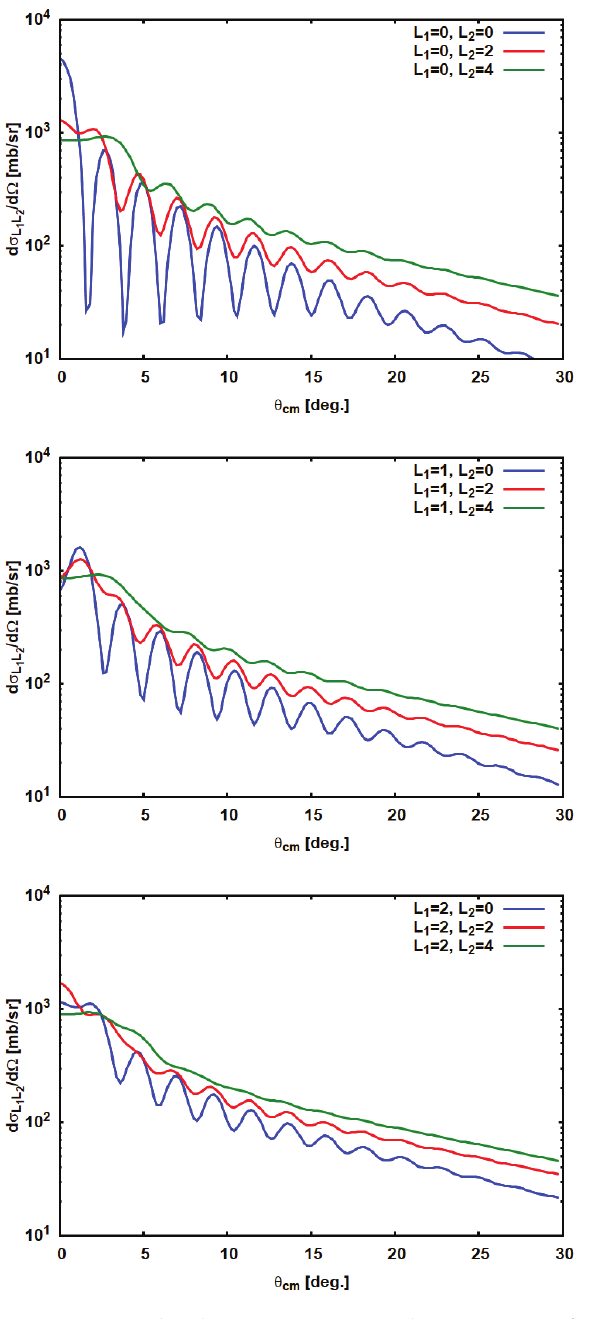
Figure 2. Second-order DSCE unit strength cross sections for the reaction 18 O + 40 Ca → 18 N + 40 Ar at T lab = 270 MeV. From top to bottom, results are shown for total angular momentum transfer in the first single charge exchange (SCE) interaction L 1 = 0,2 and the second SCE interaction L 2 = 0,2,4, respectively. The average excitation energy was chosen as ω γ = 10 MeV. The angular range corresponds to momentum transfers up to 1000 MeV/c. Optical potentials and transition potentials are calculated in a double folding approach by using the (newly derived) nucleon–nucleon (NN) T-matrix at T lab = 15 MeV, parameterized as in References [24,25]. Optical potentials are calculated with Hartree–Fock–Bogoliubov (HFB) ground state densities according to Reference [18]. The cross sections are calculated by using average form factors derived from QRPA transition densities as discussed in the text. For comparison, SCE unit strength cross sections are shown in Figure